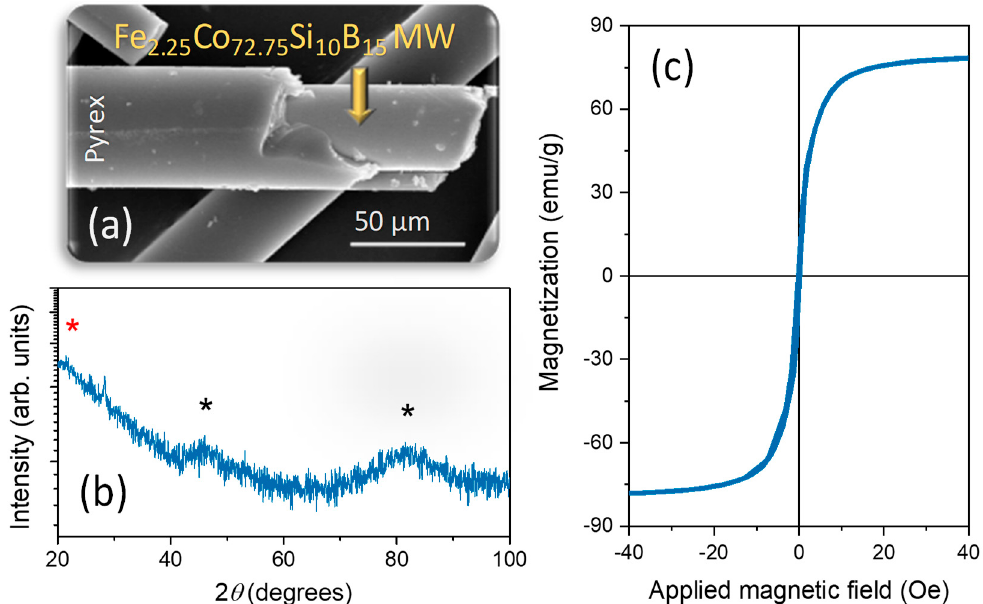
Figure 2. ( a ) The scanning electron microscopy (SEM) image, ( b ) X-ray diffraction (XRD) pattern, and ( c ) magnetic hysteresis loop of Co-based MWs. The amorphous contributions of the Pyrex and the Co-based alloy are indicated by red and black asterisks, respectively, in Figure b. The hysteresis loop is performed in one single Co-based MW at 25 °C.